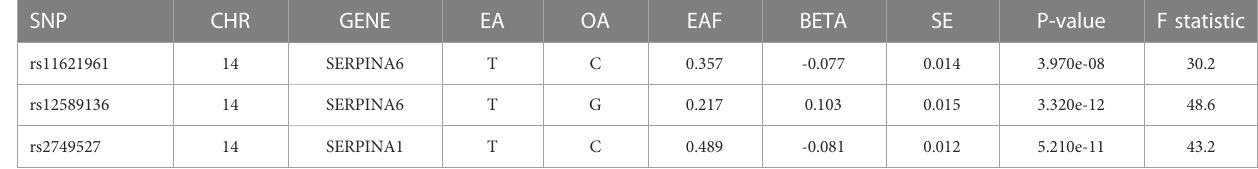
TABLE 3 Summary of single nucleotide polymorphisms used to instrument plasma cortisol levels used in the primary analysis. SNP